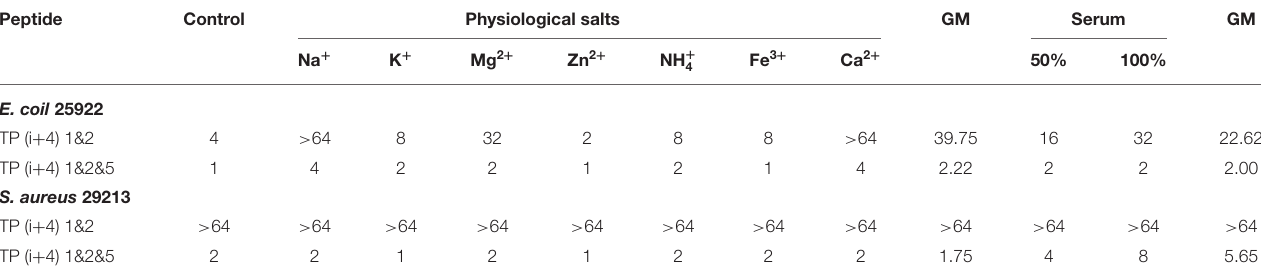
TABLE 4 | MIC ( µ m) values of designed peptides in the presence of physiological salts and serum. Peptide